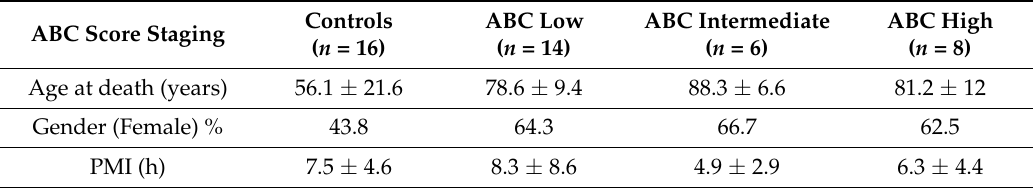
Table 2. Summary of characteristics of subjects included in the analysis sorted by ABC score. ABC Score Staging